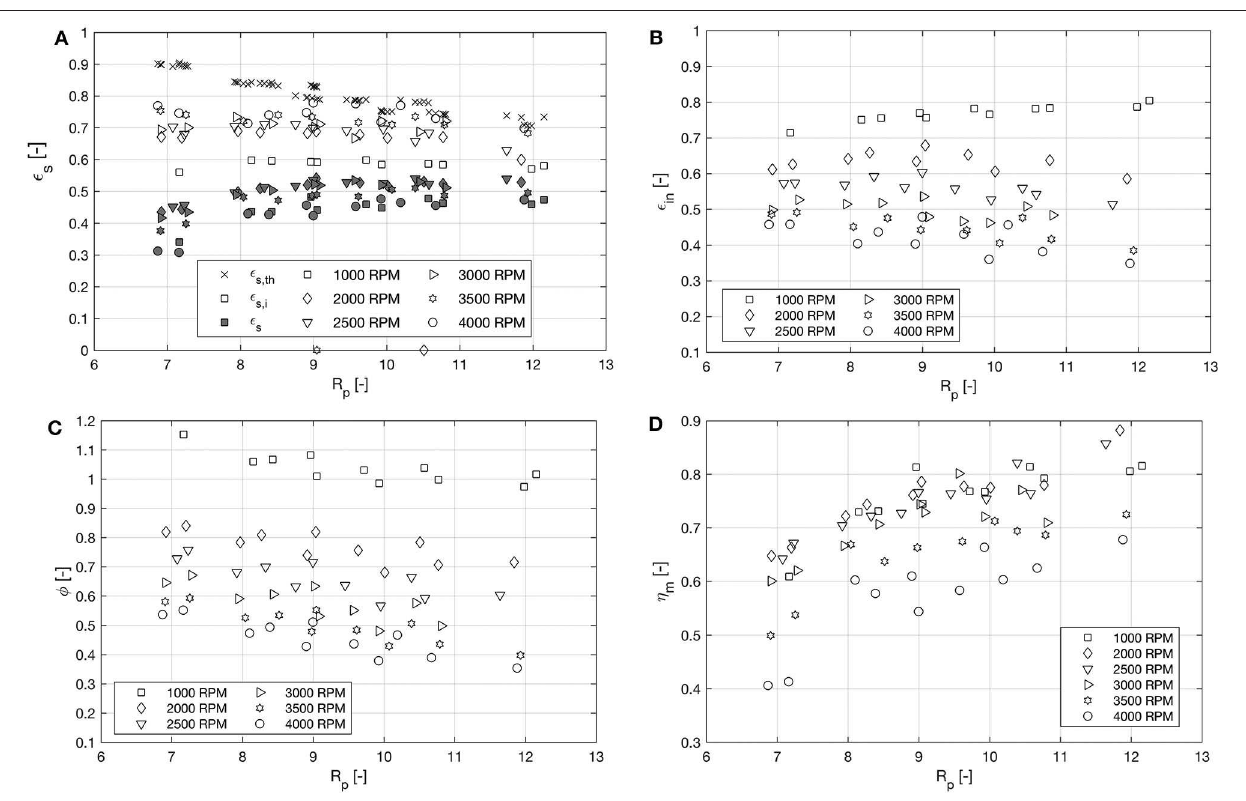
FIGURE 8 | Performance indicators in terms of pressure ratio. (A) Isentropic efficiency disaggregation; (B) Diagram factor; (C) Filling factor; (D) Mechanical